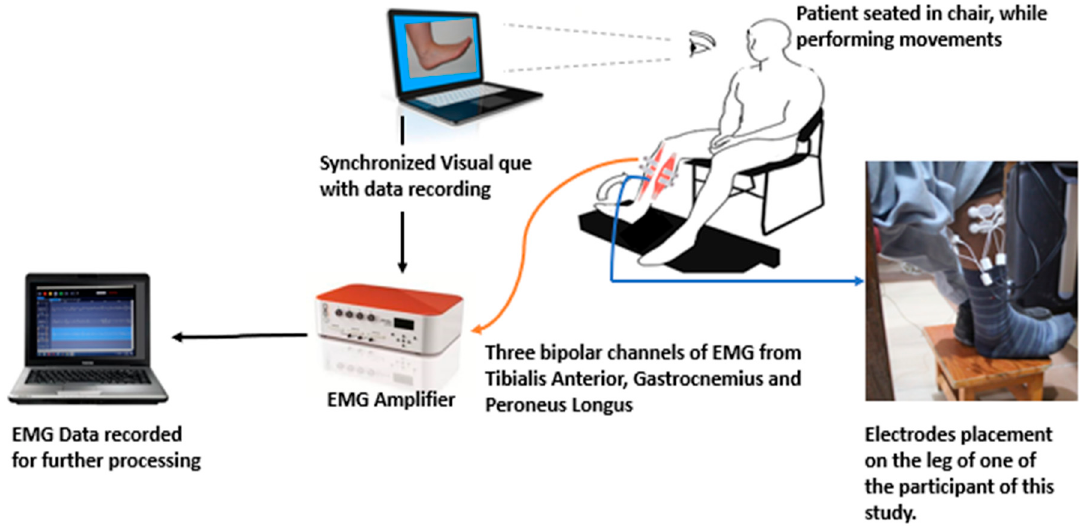
Figure 1. An illustration of the electromyography (EMG) data recording setup while the patient was performing move ‐ ments.